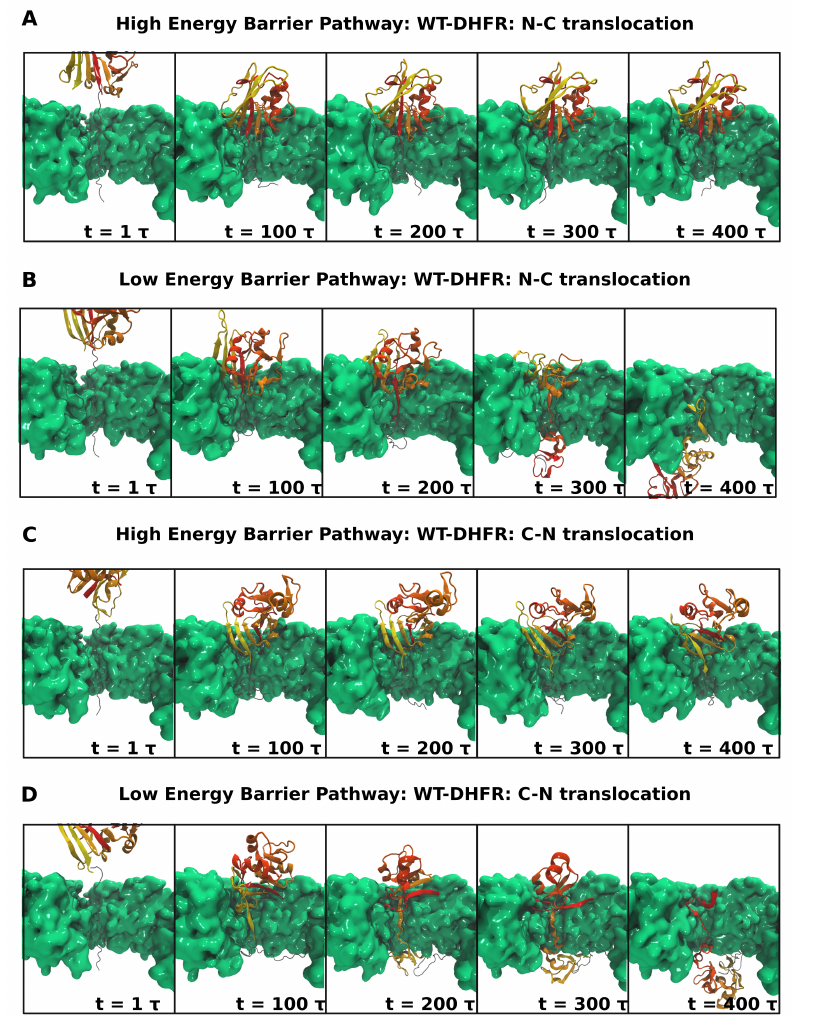
Figure 7. Dynamic orientation of wild-type DHFR at the ClpY pore lumen. The time-dependent orientation of DHFR (color-coded according to secondary structure) near the ClpY ∆ I (green) pore lumen is shown in translocation in the ( A , B ) N-C direction in the ( A ) high- and ( B ) low-energy barrier pathways and ( C , D ) C-N direction. Two ClpY protomers are not shown for